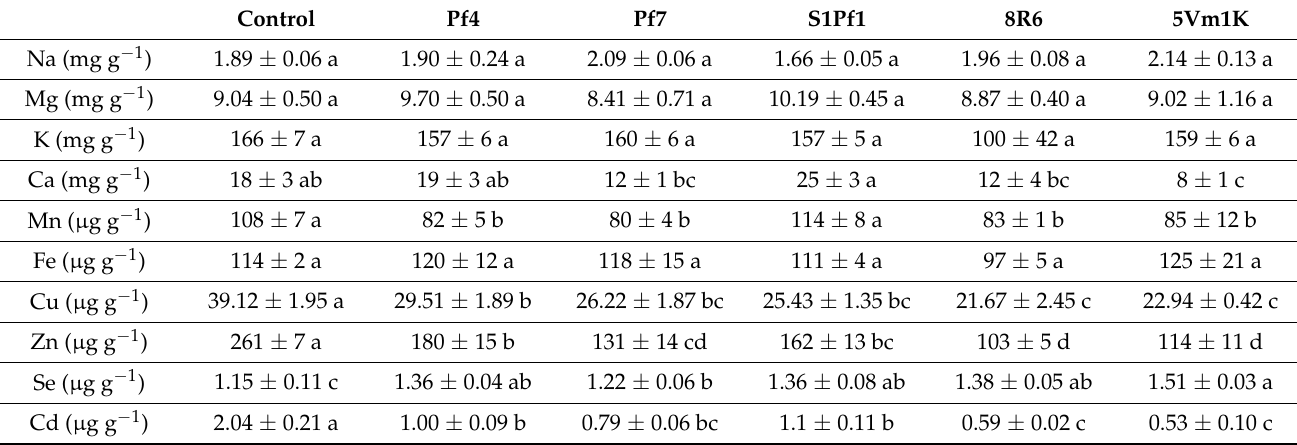
Table 5. Mineral concentrations in the bulb of Allium cepa inoculated or not (Control) with different bacterial strains ( P. fluorescens Pf4, P. protegens Pf7, P. putida S1Pf1, P. migulae 8R6, and Pseudomonas sp. 5Vm1K). The mean and standard errors are presented ( n = 3). Different letters in the row indicate significant differences among the treatments according to ANOVA followed by the LSD Fisher’s test ( p <